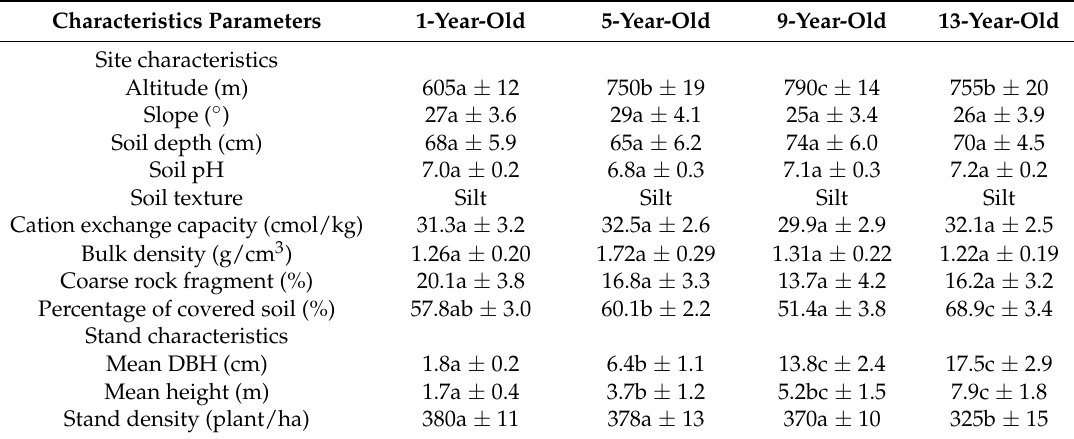
Table 1. Site characteristics and stand characteristics of four age classes of J. regia plantations ( n = 3). Characteristics